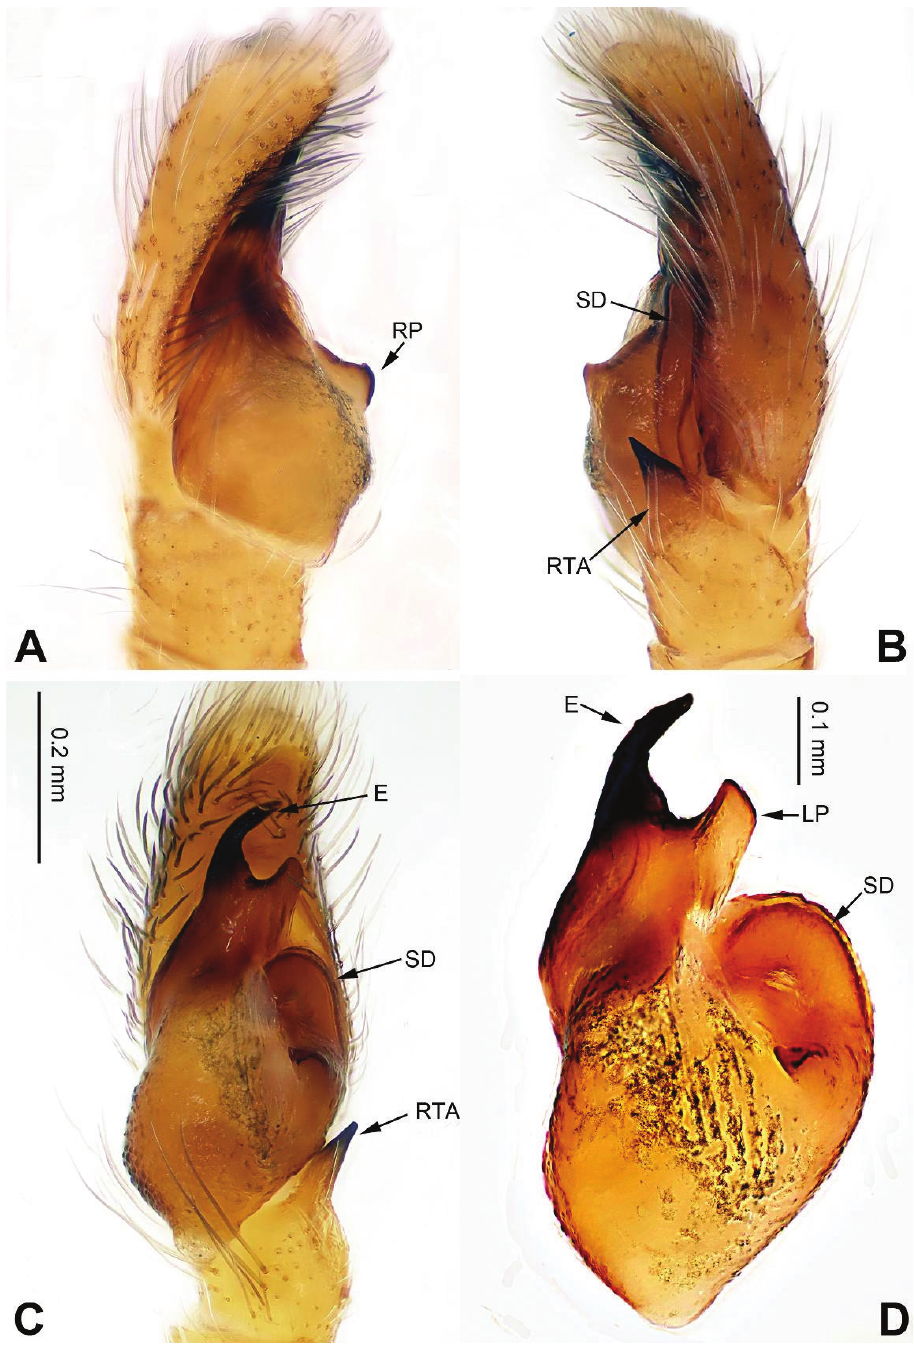
Figure 32. Palp of Phintella lepidus sp. n., male holotype. A prolateral B retrolateral C ventral D bulb, ventral. Scale bar equal for A–C